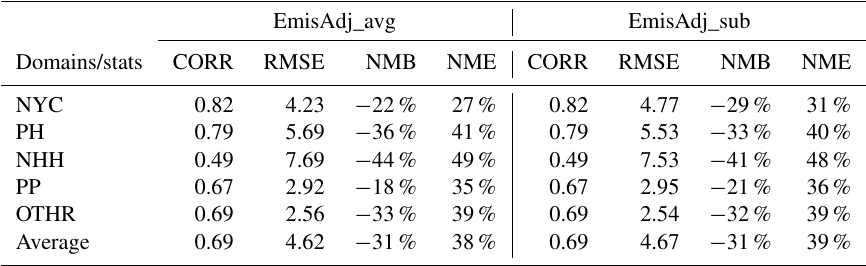
Table 5. Same as Table 4 but for NO 2